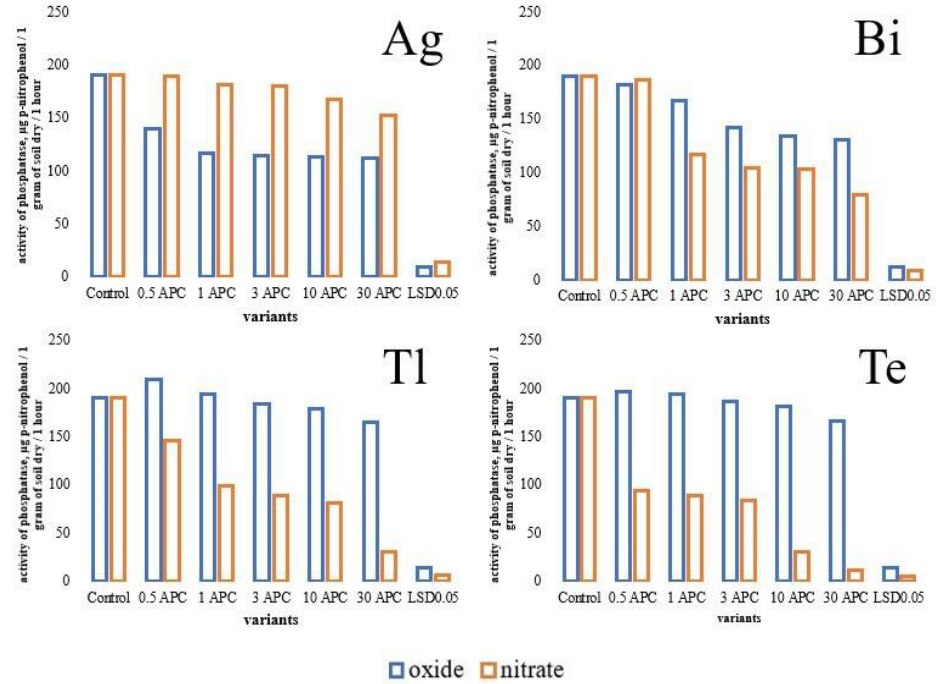
Figure 4. Changes in activity of phosphatase in haplic chernozem under pollution with oxides and nitrates of Ag, Bi, Tl, and Te, µ g p-nitrophenol/1 g of soil dry/1 h. Ag nitrate had a less toxic effect on activity of phosphatase in haplic chernozem. At 0.5, 1, and 3 APC of Ag nitrate, no significant decrease in activity relative to the control was observed. A decrease in enzyme activity was observed at 10 and 30 APC of Ag nitrate by 12 and 20% below the control. Bi oxide at a minimum concentration (0.5 APC) had no effect on activity of the enzyme. With an increase in the concentration from 1 to 30 APC of Bi oxide, activity inhibition was observed by 12–32% below the control. Bismuth nitrate in 0.5 APC also did not significantly affect enzyme activity. At the same time, when the concentration of 1 APC was reached, activity inhibition was 38%, and with an increase in the concentration of Bi nitrate from 3 to 30 APC, 44–58% below the